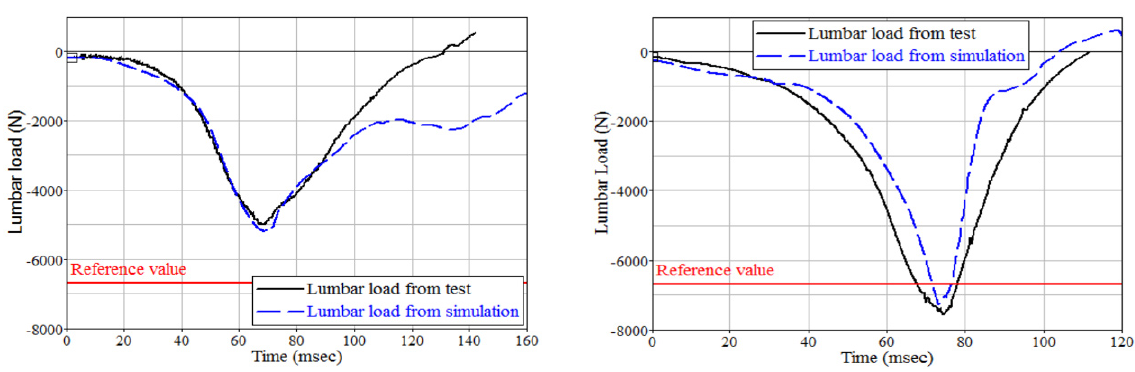
Figure 10. Comparison of occupant-sustained lumbar load for bare iron seat under FAR 25 (left) and for a 5-in-thick industry cushion under FAR 23 (right) from this study and sled test [18].